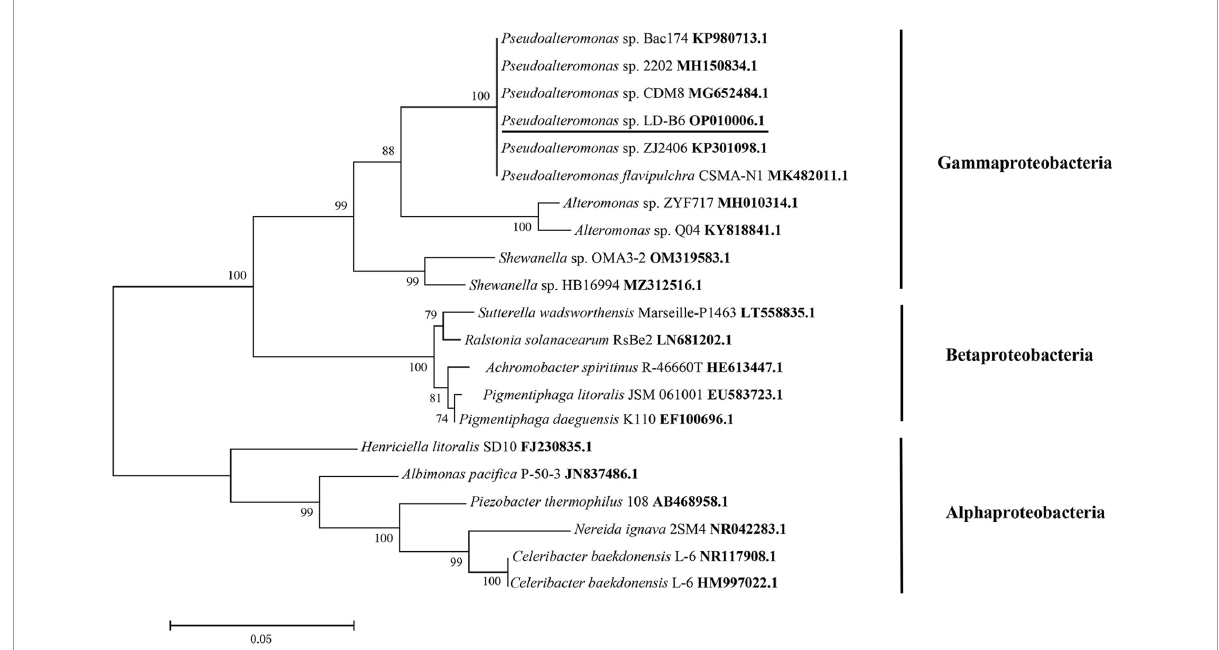
FIGURE2 Phylogenetic tree of algicidal bacterial strain LD-B6 based on 16S rDNA sequence. Support of nodes > 50% is shown. Bar 0.05 means a nucleotide substitution rate of 0.05.